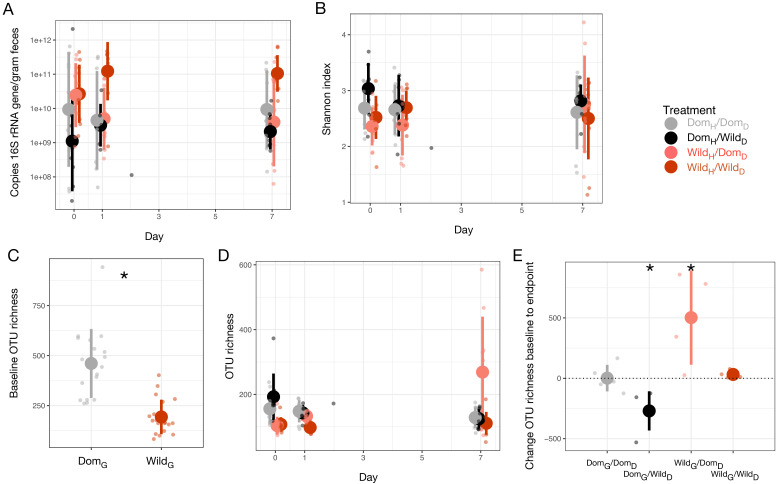
Select microbial parameters under canid diet swap.(A) Microbial loads of experimental groups over time.(B) Shannon index by experimental groups over time. (C) OTU richness differed between genotypes on day 0. * indicates p<0.05, Mann–Whitney U test. (D) OTU richness by experimental groups over time. (E) Change in OTU richness from day 0 to day 7 differed significantly from 0 in opposite directions for animals on altered diets (DomG/WildD and WildG/DomD). * indicates p<0.05, one-sample Wilcoxon test, and dashed line indicates a shift of 0. Large circles are means; bars show standard deviations.